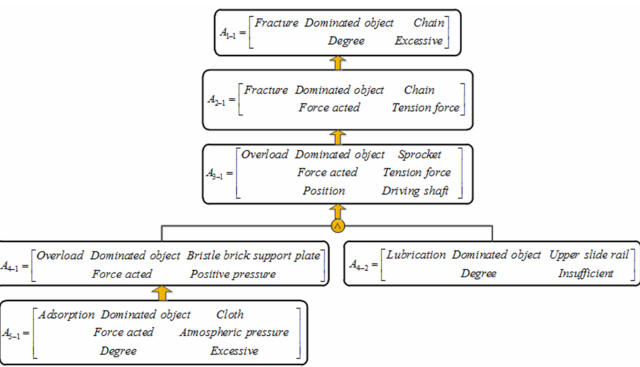
Figure 9. Affair-element implication reasoning of transmission chain fracture